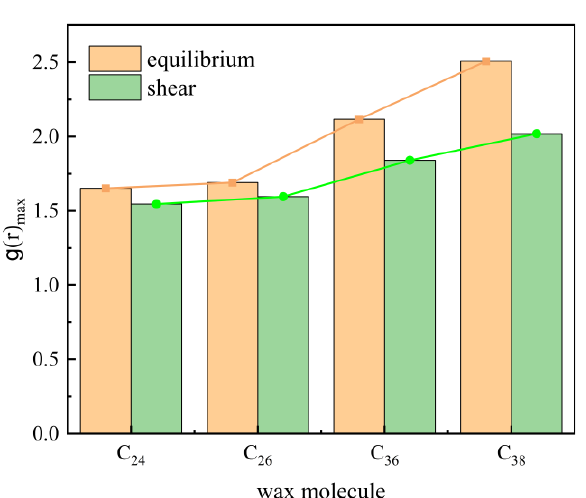
Figure 15. Comparison of the RDF peaks of different wax molecules before and after shearing.